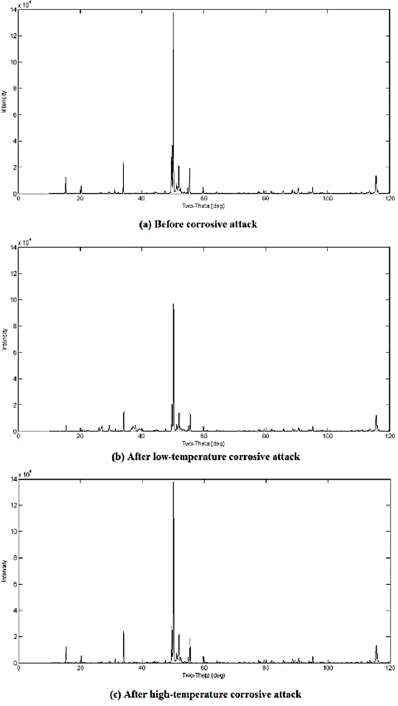
Figure A30. Qualitative XRD analysis of the surface of 316-A-Sn ( a ) before corrosive attack, ( b ) after low-, and ( c ) high-temperature corrosive attack.